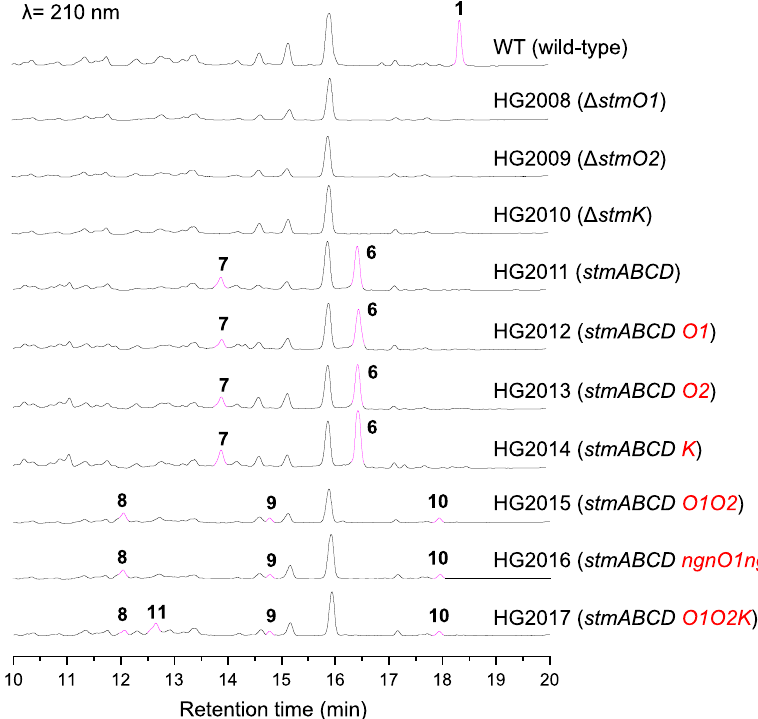
Fig. 2 HPLC analysis of wild-type and recombinant strains. The highlighted peaks were intermediates or shunt metabolites in the stm